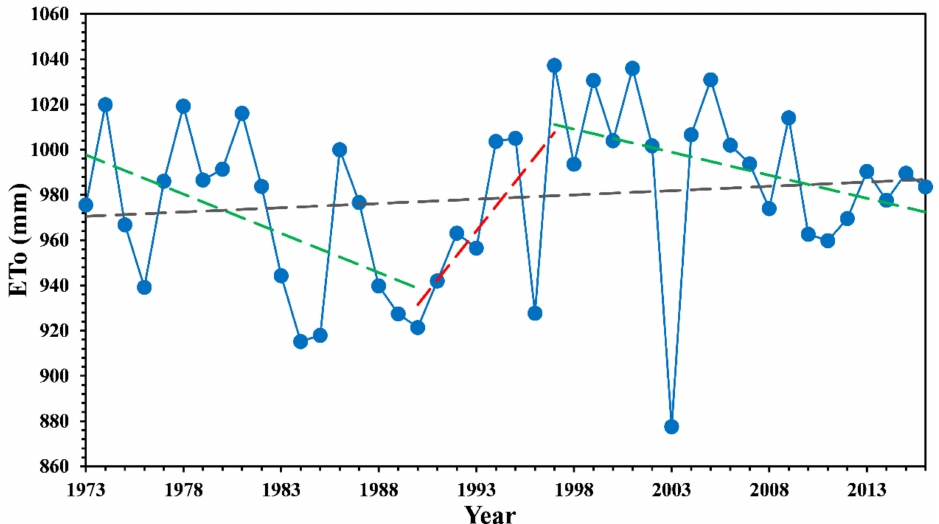
Figure 6. Variation in annual ETo and change-points in the ETo series during 1973–2016. (The gray dashed line represents the trend of ETo during the whole study period. The red and green dashed lines represent the upward trends and downward trends of ETo during the subperiods,